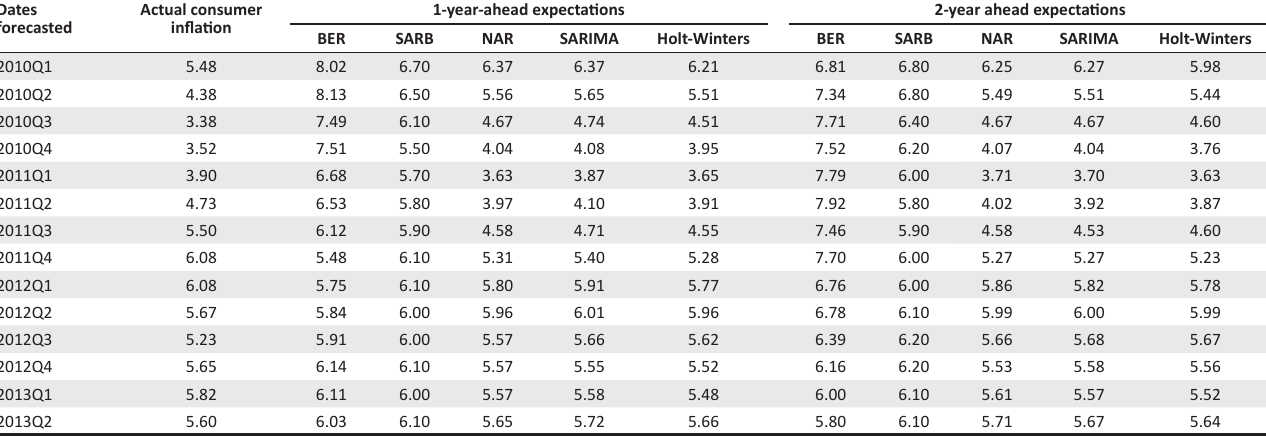
TABLE 3: Inflation expectation comparison with Bureau for Economic Research and South African Reserve Bank – Quarterly approach. Dates forecasted